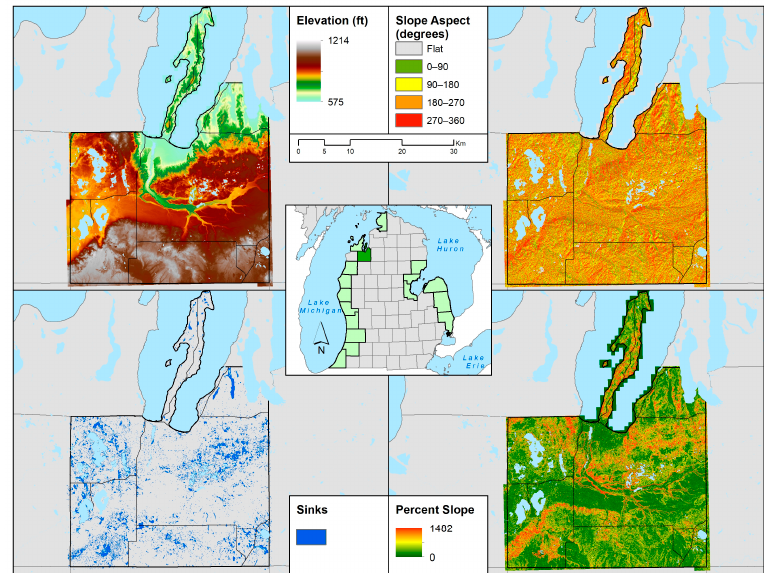
Figure 4. Spatial patterns of the three topographic variables analyzed in the models including: percent slope, slope aspect which is indicative of the direction of slope, and location of sinks (topographic depressions) for Grand Traverse County, northern MI. Elevation (ft), from which the three topographic variables were generated, is also included.